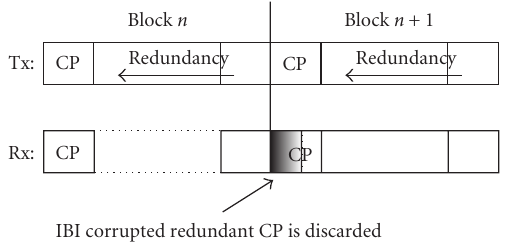
Figure 6: Prolonging of blocks in multipath channel results in interblock interference; currently the redundant CP samples are all discarded.